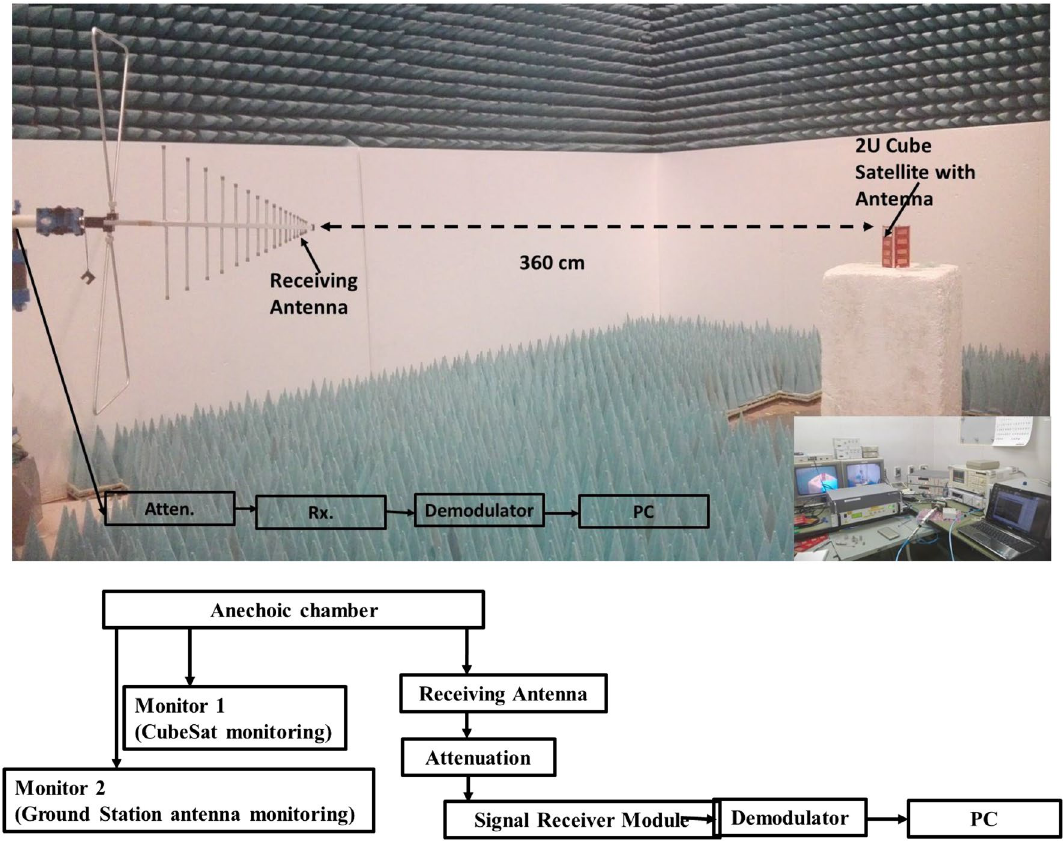
Figure 12. FSPL estimation in the anechoic chamber and maximum attenuation measurement until signal demodulation.